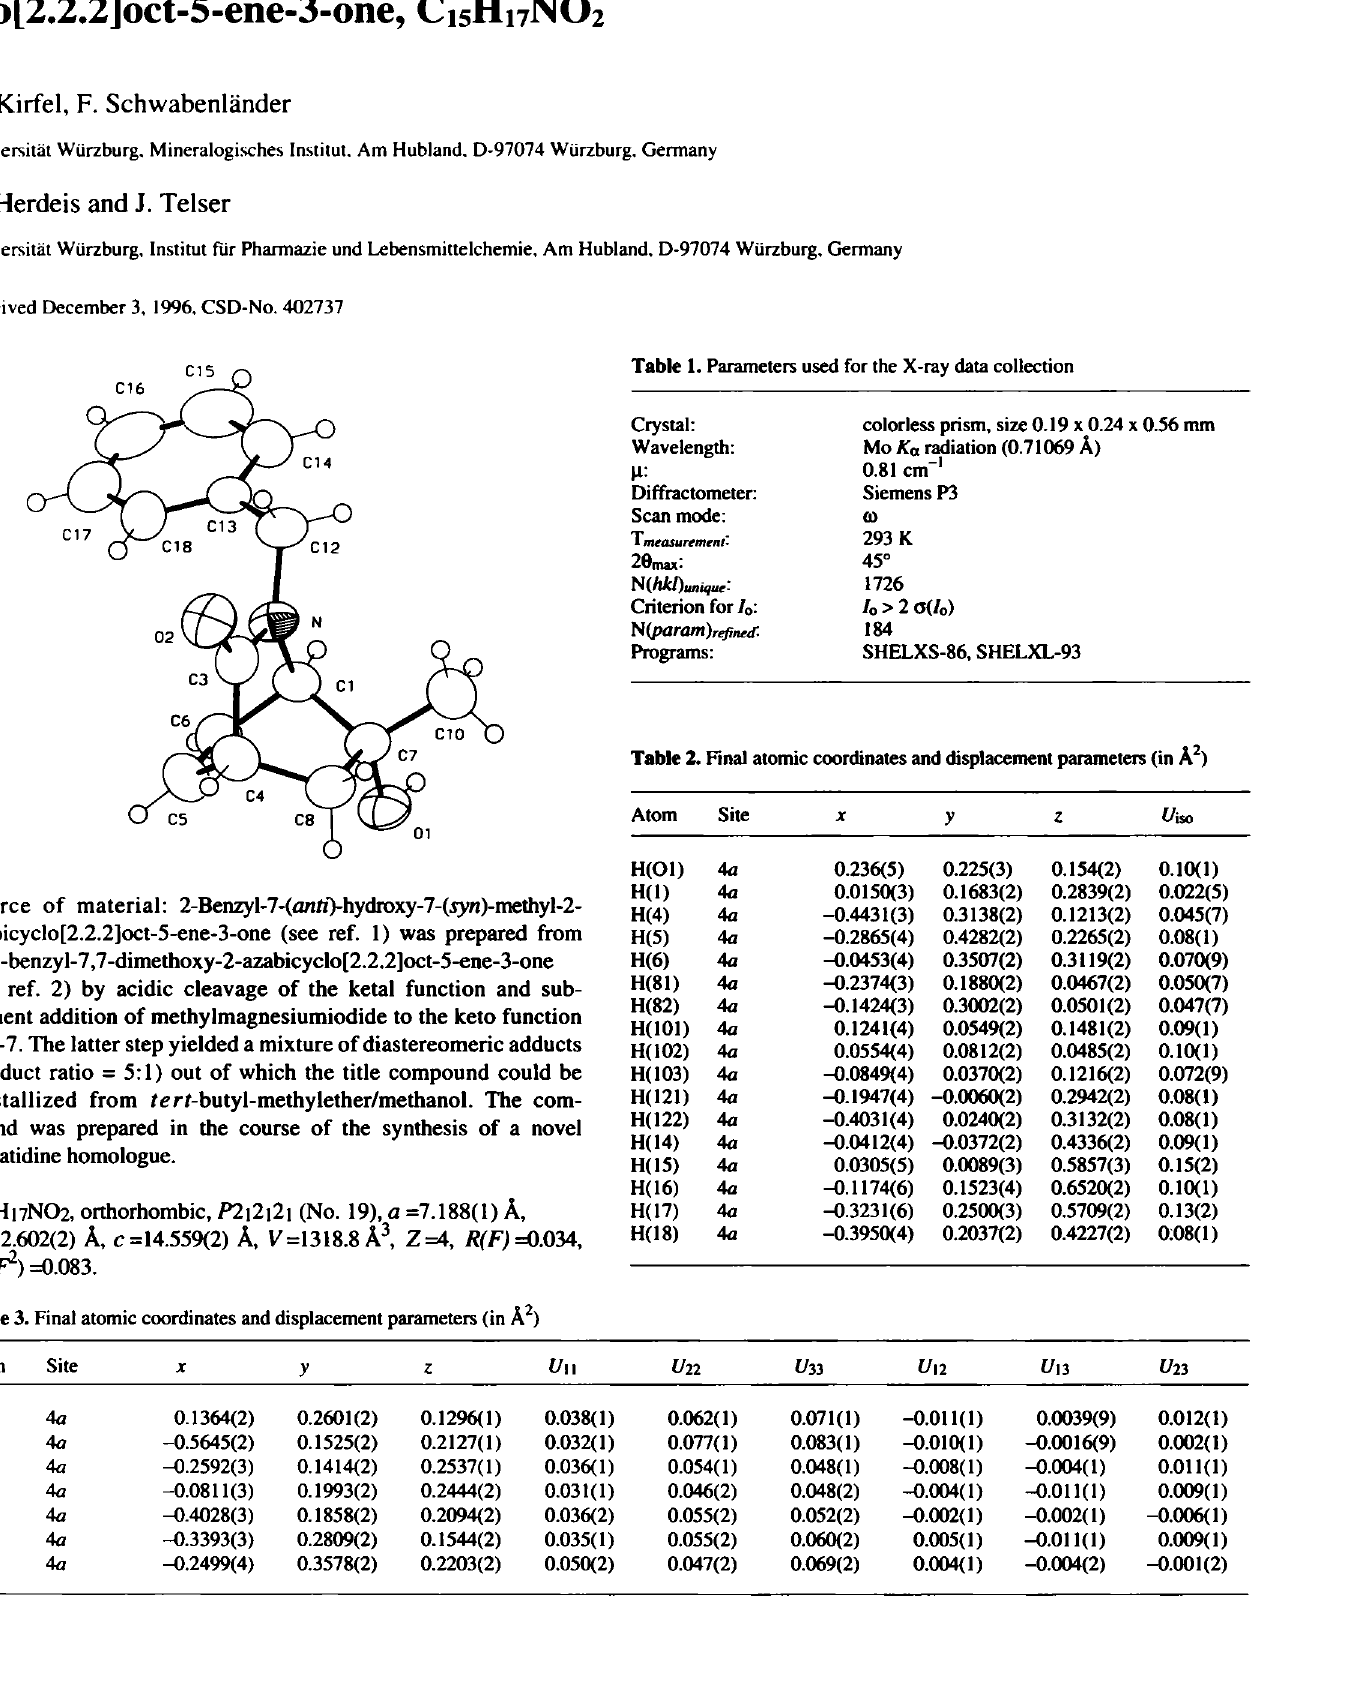
Table 1. Parameters used for the X-ray data collection Crystal: